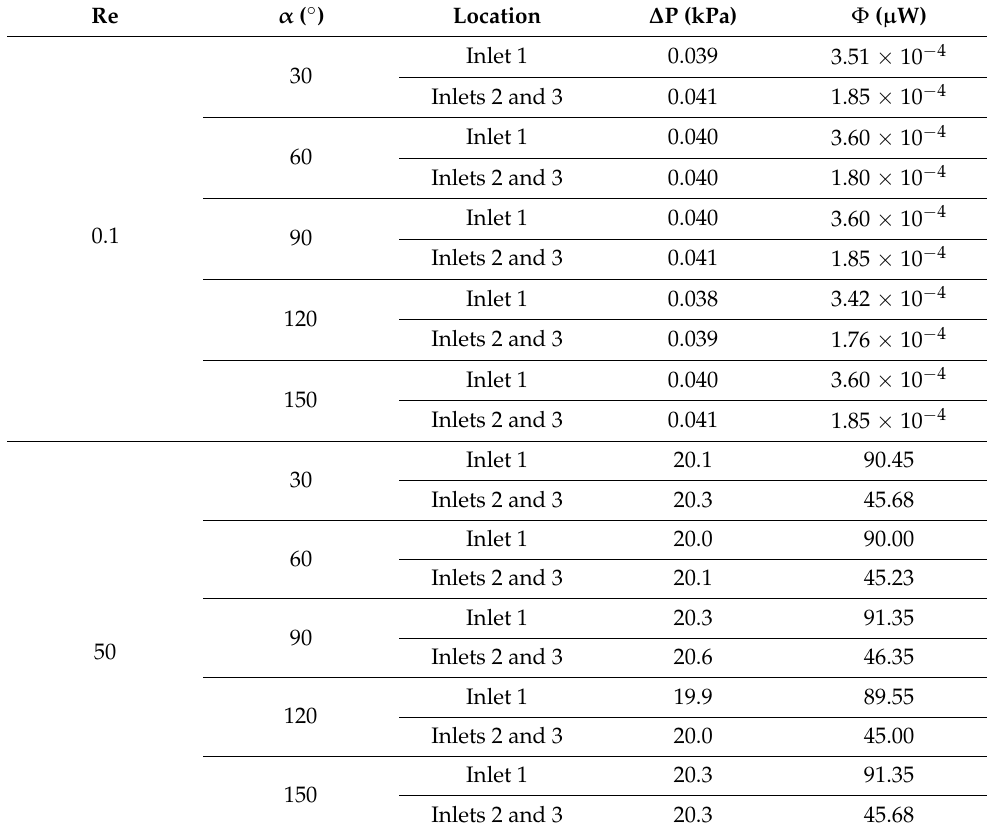
Table 4. The pressure drops and the pumping power consumption with different inflow angles.